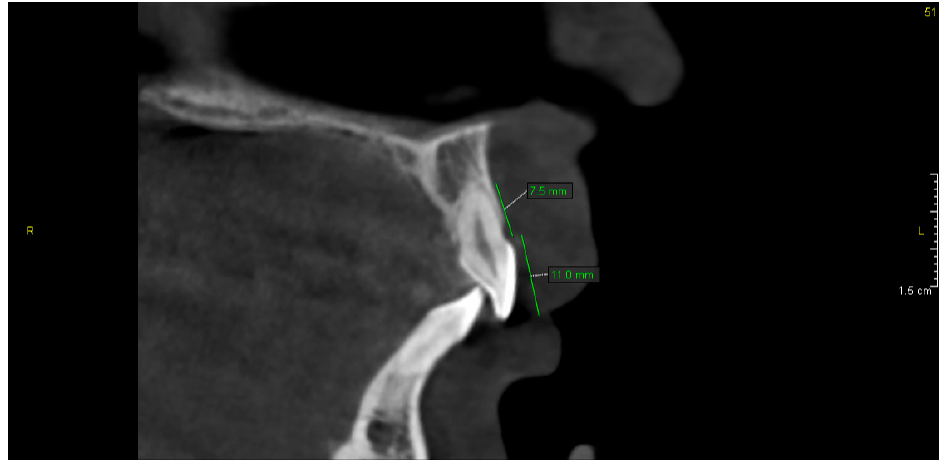
Figure 3. Patient 1. Rhizomicria of upper left central incisor (21)—Sagittal reconstruction from CBCT.